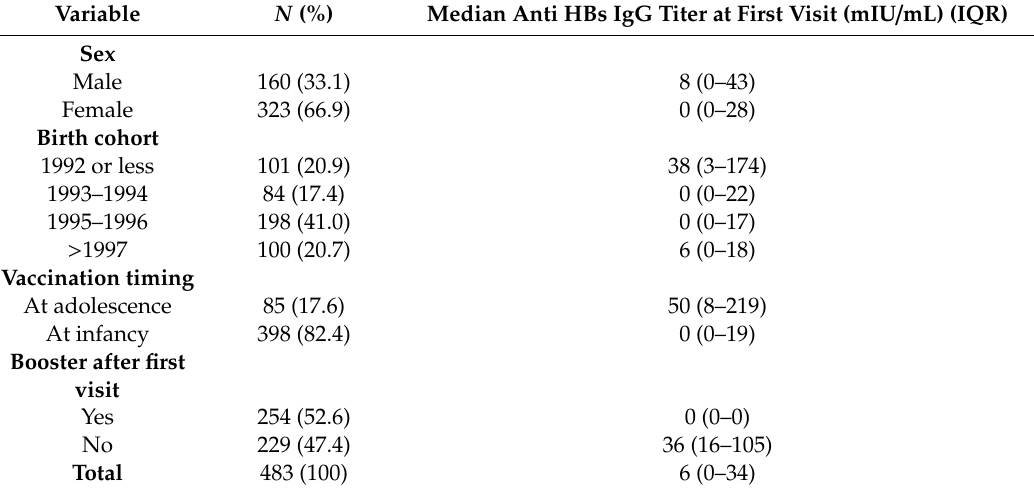
Table 1. General characteristics of nursing students in relation to the median of serum antibodies against hepatitis B surface antigen (anti-HBs) IgG titers at the first